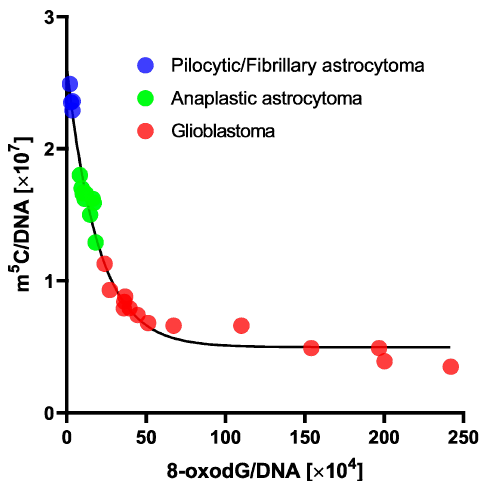
Figure 4. One phase decay curve of m 5 C in relation to 8-oxo-dG contents in DNA from human brain tumors tissues. 8-oxo-dG allows subdividing gliomas within a similar total DNA methylation level. 3.3. Total DNA Methylation and 8-oxo-dG Contents in Peripheral Blood Samples